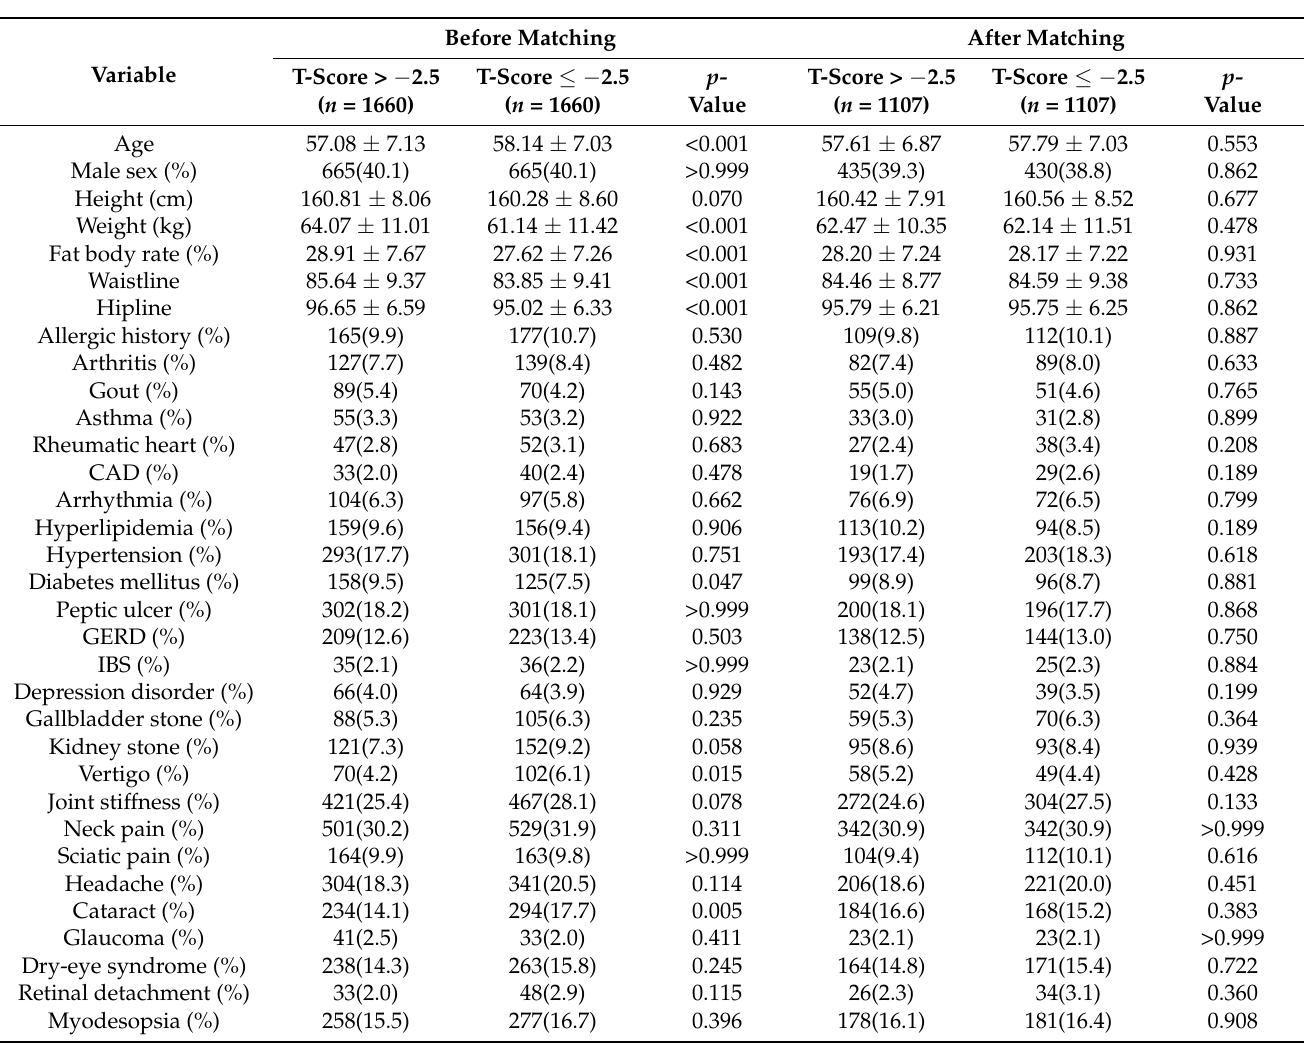
Table 1. Demographic characteristics of body compositions and medical